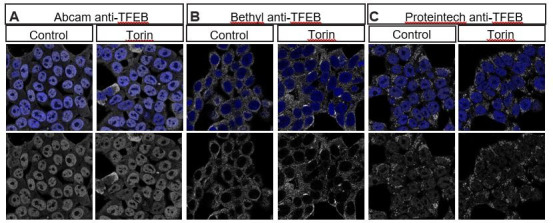
Multiple commercially available TFEB antibodies fail to show specific staining as demonstrated by lack of increase in nuclear localization of TFEB after treatment with Torin1, an mTOR inhibitor known to induce nuclear translocation of TFEB.HEK293T cells stained with (A) Abcam anti-TFEB ab174745, (B) Bethyl anti-TFEB A303-673A and (C) Proteintech 13372-1-AP in control (left) or treated with 2μm Torin for 2 hours.